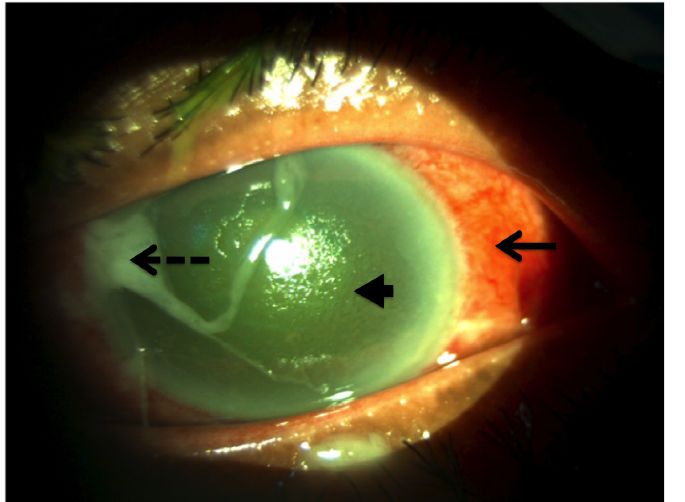
Image 1. Image of patient’s left eye, taken by ophthalmology, demonstrating diffuse conjunctival injection without limbic sparing (solid arrow), mucopurulent drainage (dashed arrow) and a cloudy anterior chamber (arrow